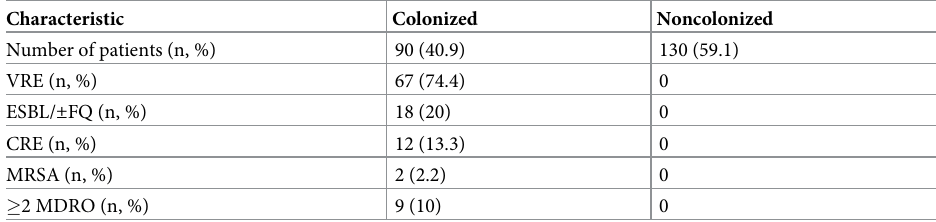
Table 2. Microbiological